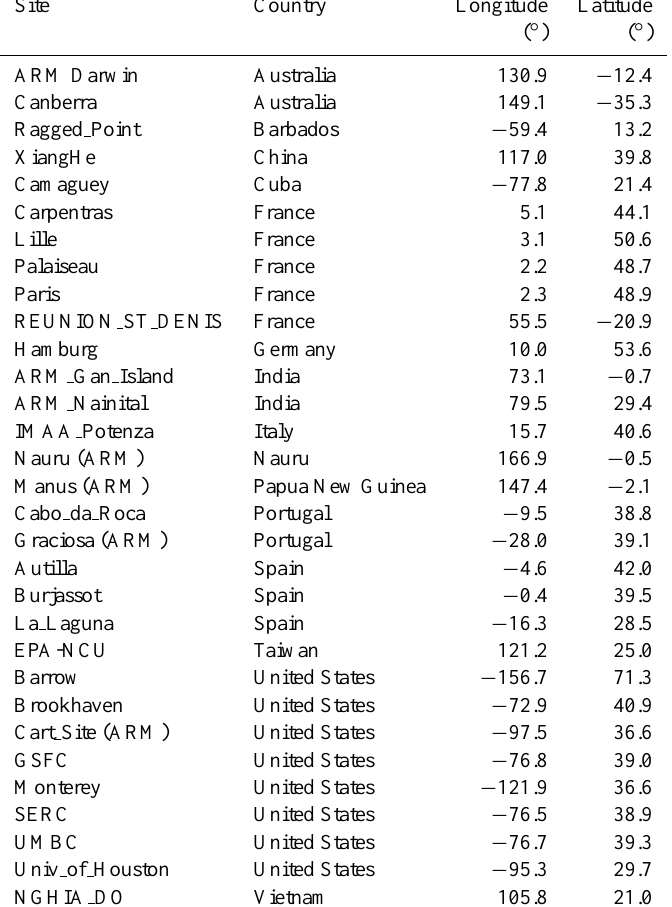
Table 1. A list of AERONET cloud-mode sites where zenith radiance measurements at 1640nm are available in